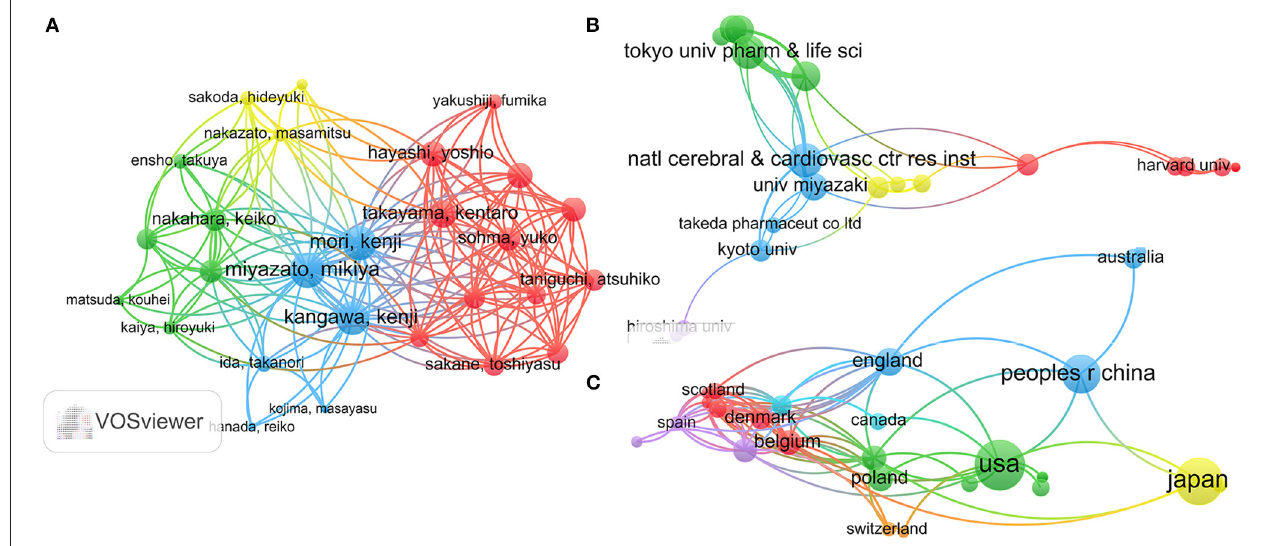
FIGURE 5 | Document coupling analysis. The volume of the circle reflects the number of literatures, and the color represents the clustering. The larger the circle represents the higher frequency of occurrence. Smaller distance between two circles means more co-occurrence. The greater the density of lines between circles, the